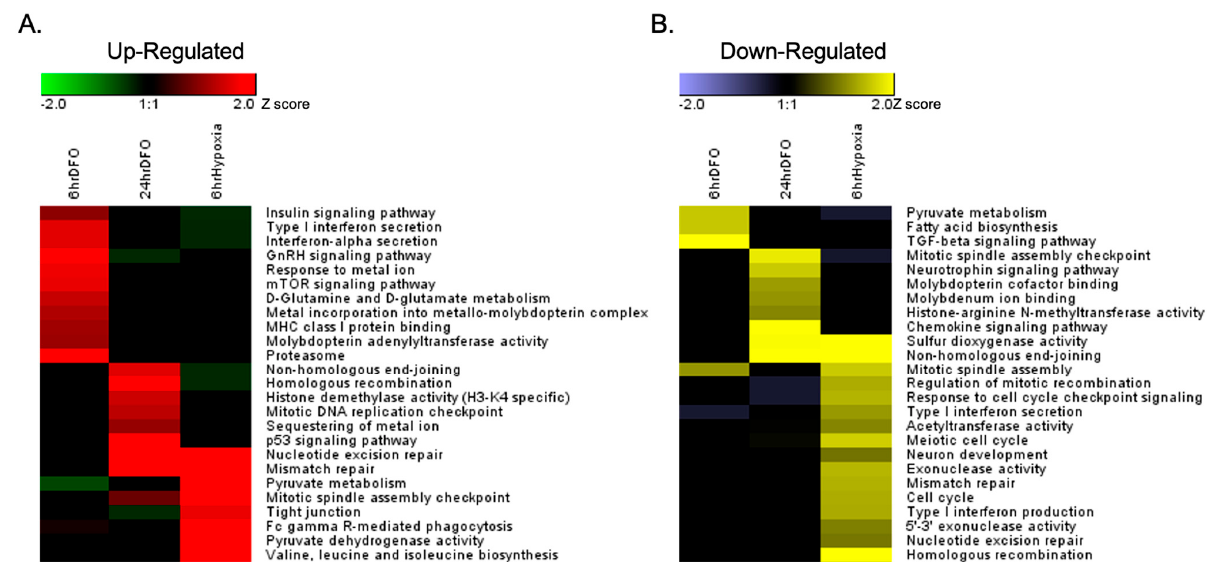
Figure 4. Clustering analysis of the quantitative phospho-proteome datasets with the Kyoto Encyclopedia of Genes and Genomes (KEGG) Pathway. SILAC quantification ratios of all phospho-peptides for each treatment were divided into four quantiles based on the normalized log 2 (Heavy/Light) SILAC ratios (Q1 < − 1, − 1 ≤ Q2 < 0, 0 ≤ Q3 ≤ 1, Q4 > 1). An enrichment analysis of the KEGG pathway for each quantile was performed using the hypergeometric test with Benjamini–Hochberg adjustment. Phospho-proteome annotations that were significantly upregulated in Q4 ( A ) and downregulated in Q1 ( B ) in each treatment were clustered through hierarchical clustering.